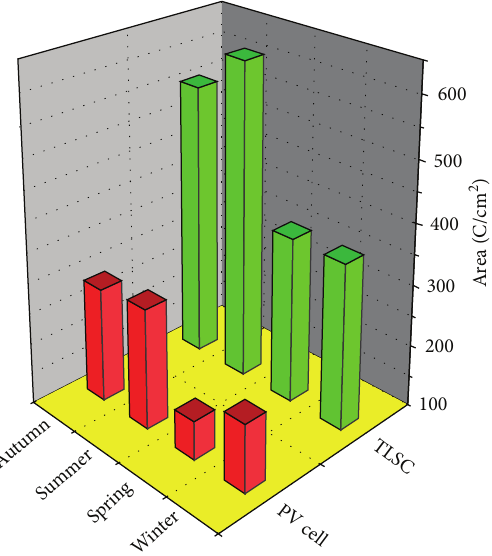
-solartimecurvesobtainedofTLSC sc